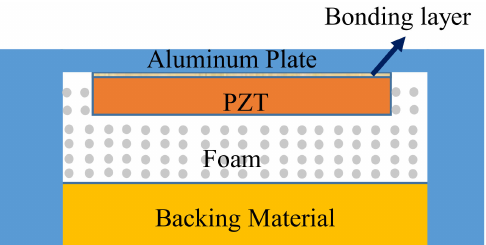
Figure 1. The cross sectional view of a typical ultrasonic sensor.